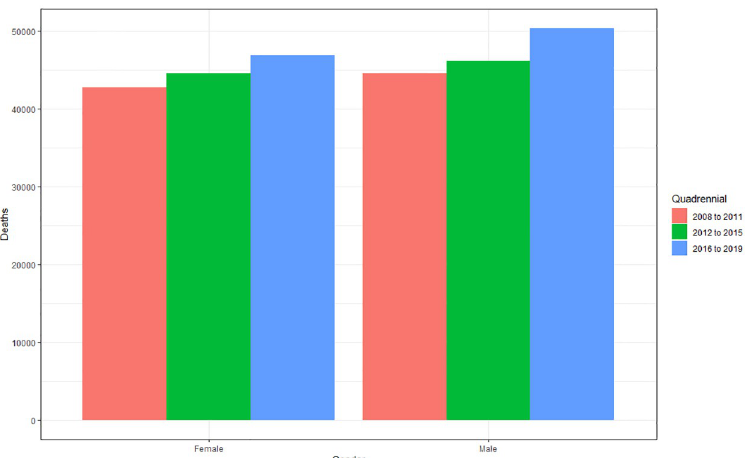
Fig 8. Average of deaths caused by cardiovascular diseases according to gender and quadrennium (2008 to 2011; 2012 to 2015; 2016 to 2019). Source: Ministry of Health–Hospital Information System of the Unified Health System (SIH/SUS)